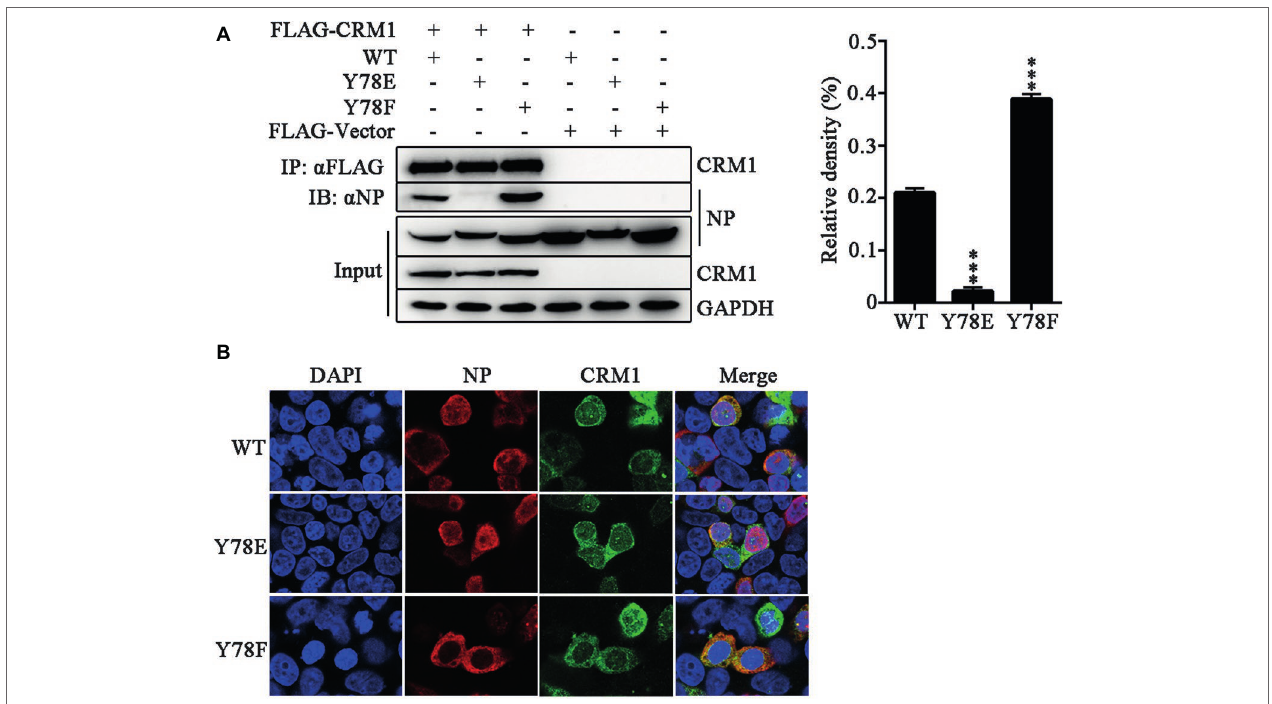
FIGURE 4 | Y78 phosphorylation negatively regulates the binding of NP to CRM1. (A) Co-immunoprecipitation (CO-IP) experiments of WT and mutant NPs with CRM1. The NP (WT, Y78F, and Y78E) with pcDNA4.0/TO-tagged plasmid and pCDNA3.0-FLAG-CRM1 plasmid were co-transfected into 293 T cells, and cells were lysed at 24 h.p.t. FLAG-CRM1 was immunoprecipitated with anti-FLAG agarose, and the associated NP was detected using rabbit anti-NP antibody (left). The relative density of immunoprecipitated NPs was normalized to immunoprecipitated CRM1 (right). Data are shown as mean + SD ( n = 3). Differences between mutant and WT NPs were evaluated using one-way ANOVA followed by Dunnett’s test. *** p < 0.001. (B) The co-localizations of CRM1 with NPs were examined by IFAs. The 293 T cells expressing FLAG-CRM1 and pCDNA4.0-NP (WT, Y78F, and Y78E) were fixed and stained with anti-NP (red) and anti-FLAG (green) antibodies at 24 h.p.t. The nucleus was stained with DAPI